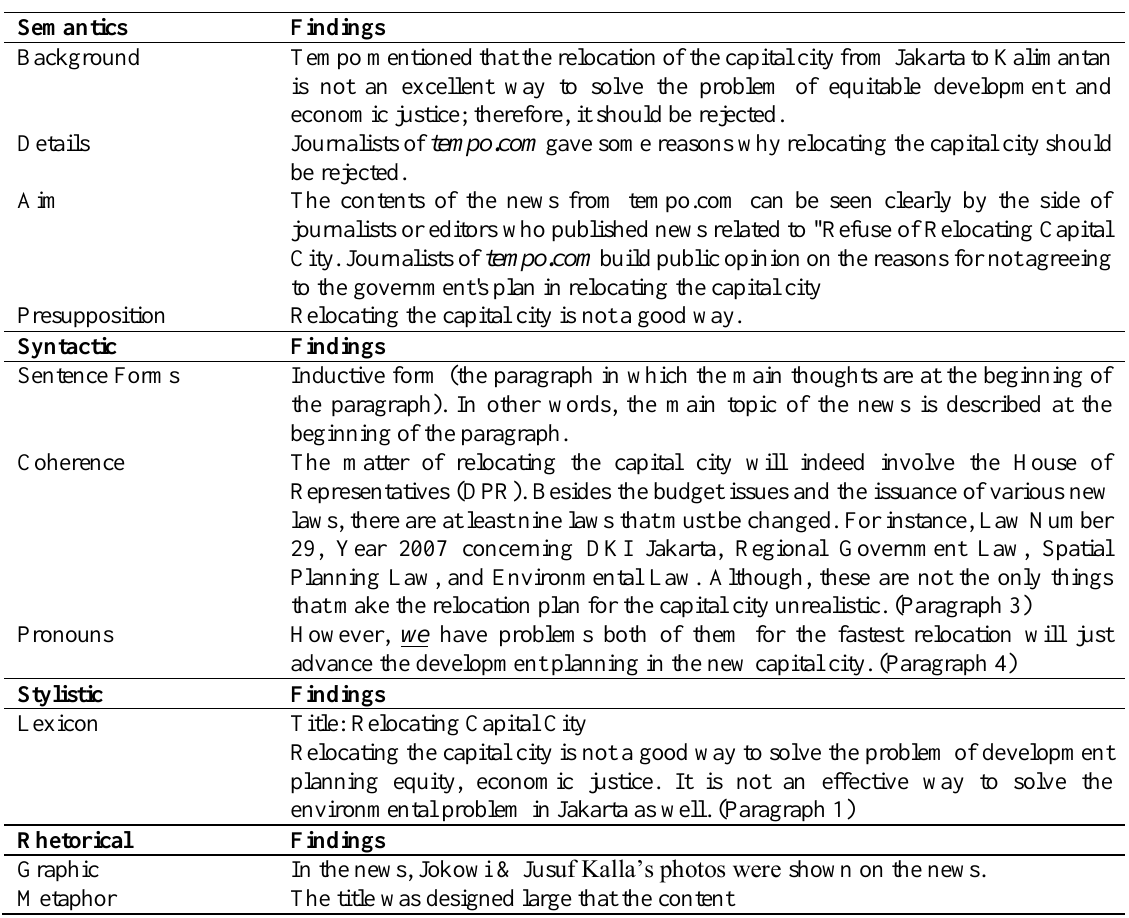
Table 4. Microstructure